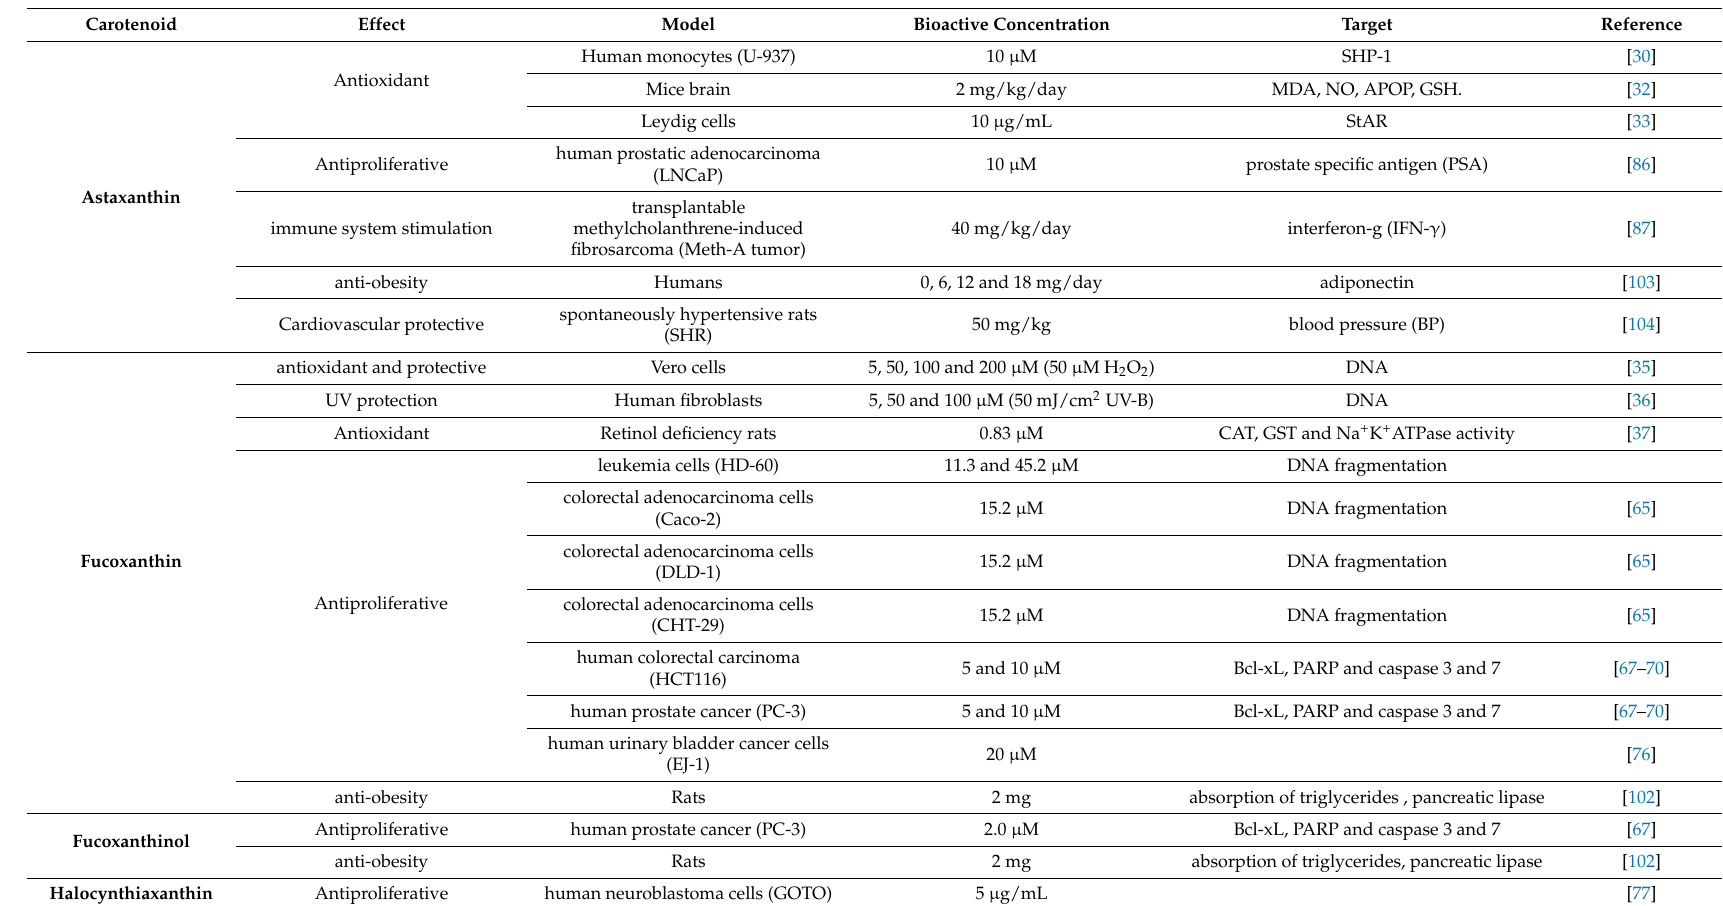
Table 1. In vitro and in vivo studies of biological roles of